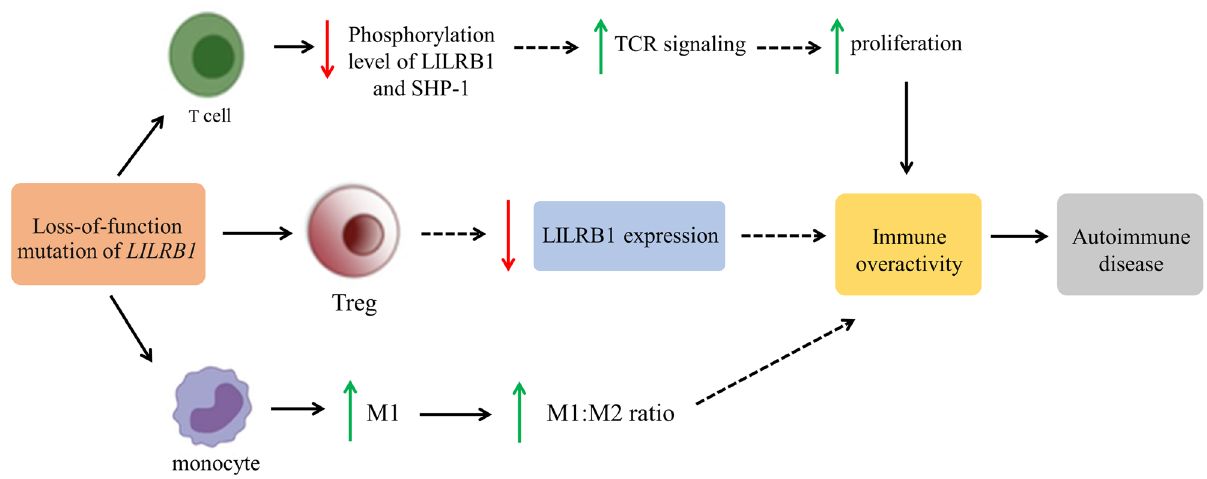
Figure 4. Proposed diagram of the loss-of-function LILRB1 variant resulting in immune over activity and autoimmune